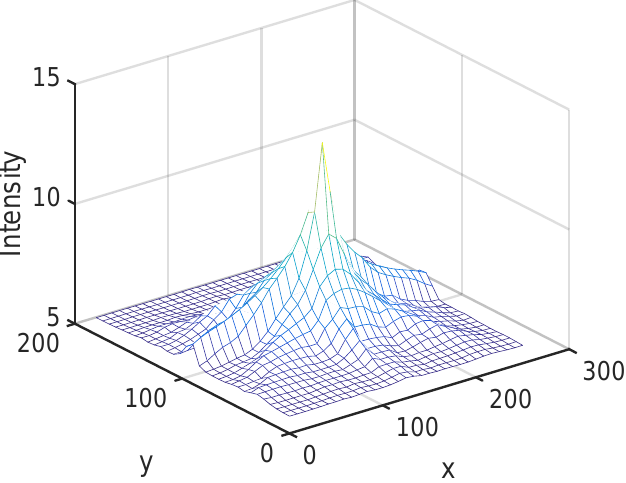
Figure 3. Model response associated with sensor location number 8 with the source intensity fixed at 3.5 × 10 9 Bq. Intensity is plotted with a logarithmic